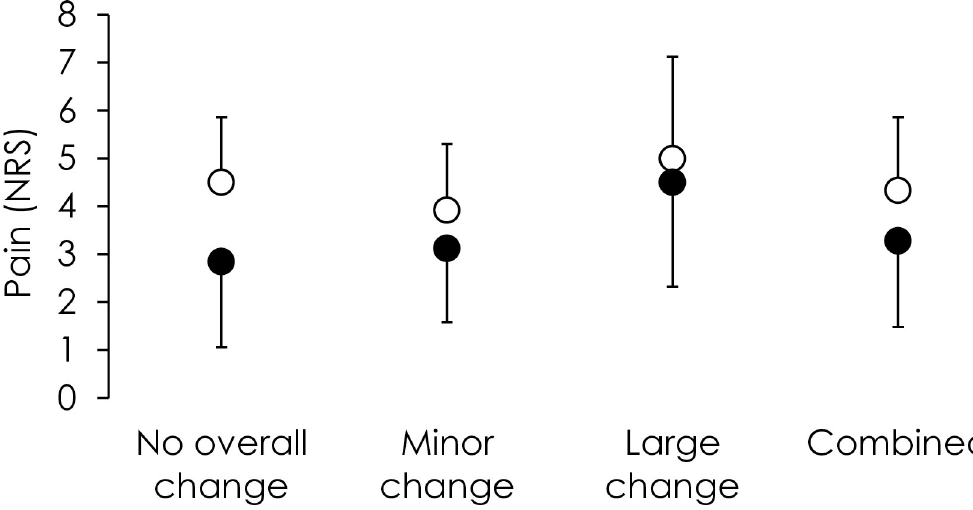
Fig 7. Pain reported at the start (first 20 epochs; open circles) and end (last 20 epochs; closed circles) for each strategy and with all strategies combined. Each strategy led to a reduction in pain, although only the “no change” strategy involved greater use of the range with reduced noxious input. The reduction in pain in the “small” and “large” change strategy was achieved despite no change in noxious input.